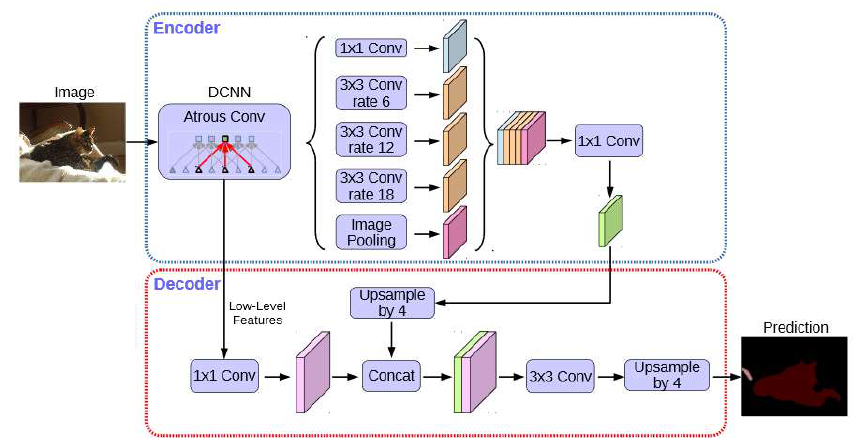
Figure 1. Block diagram of DeepLabV3+ [33].